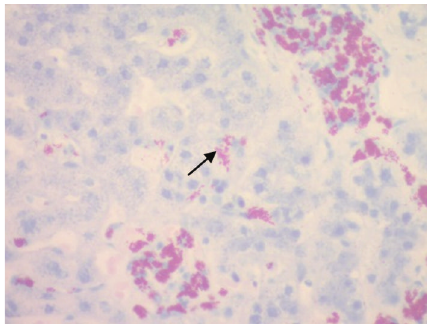
Figure 1: Ziehl-Neelsen staining of hepatic tissue showing numer- ous and tightly packed AFBs.